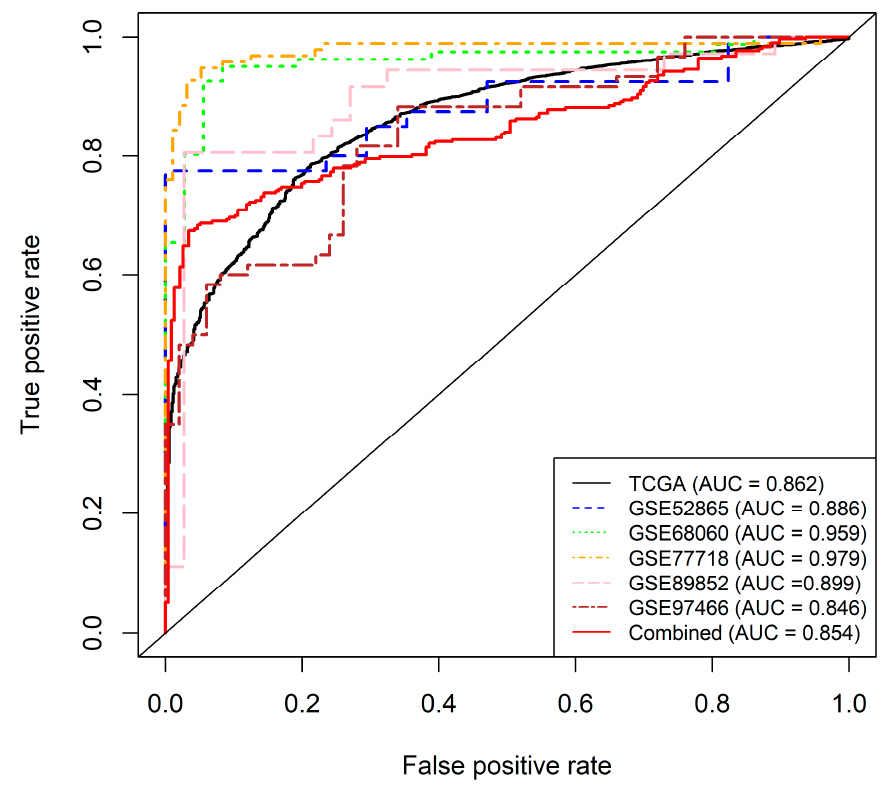
Figure 6. Receiver operating characteristic (ROC) curves for the final GSDME pan-cancer model along with the validation datasets. The black solid curve represents the training dataset, the red solid line represents the combined validation dataset, while the dotted lines represent the individual validation sets. The final model included six CpG probes; one in the gene body (Probe 3), four in the promoter region (Probes 12, 14, 18 and 20) and one in the upstream region (Probe 21) and accounted for age and tumor stage. Sensitivity and specificity at various cut-off values for the datasets are plotted. The final model yielded an AUC of 0.86 (95% CI: 0.852–0.87). At a set cut-off of 0.55, sensitivity and specificity were at 98.8%, and 93.2%, respectively, while overall model accuracy was 89.7%. The right panel shows ROC curves for the subsequent validation of the model by three external datasets. The diagonal line represents the line of no discrimination between tumor and normal tissues.